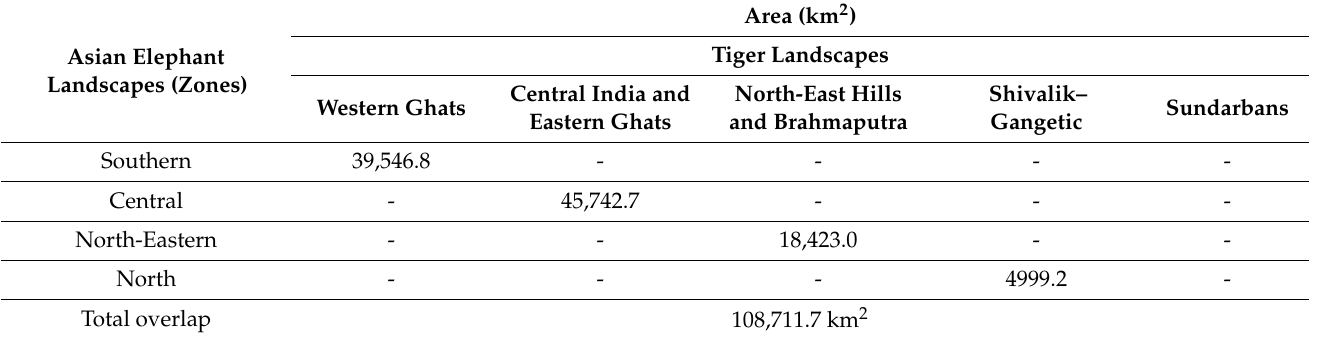
Figure 3. Overlapping habitats of elephants and tigers in India. The illustration was prepared using tiger and Asian elephant range extents as per IUCN assessments [2,3]. Table 2. Zone wise details of overlapping extant ranges of elephants and tigers in